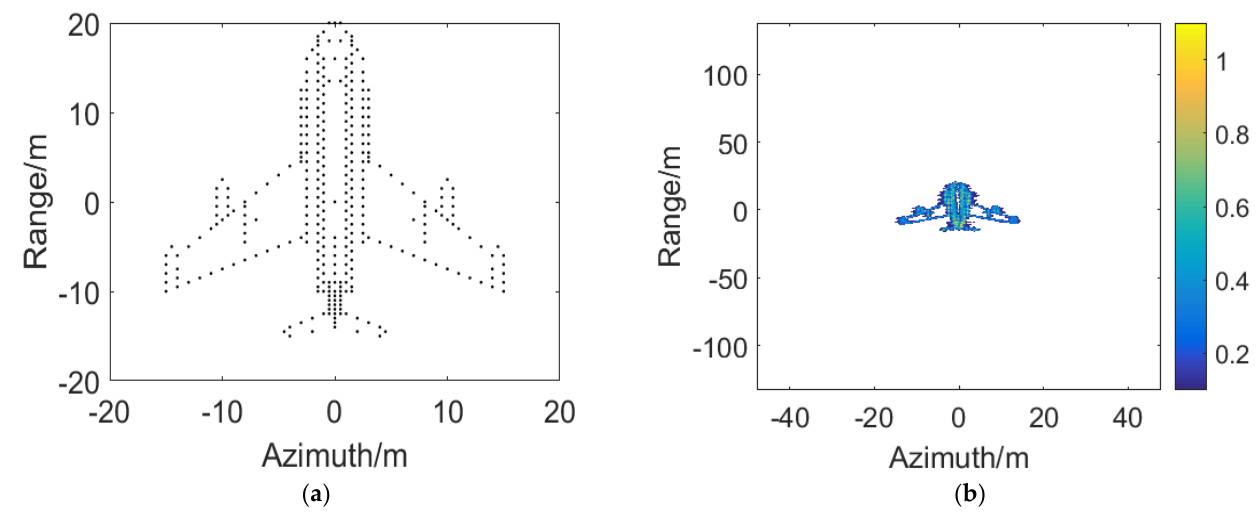
Table 1. Simulation Parameters.